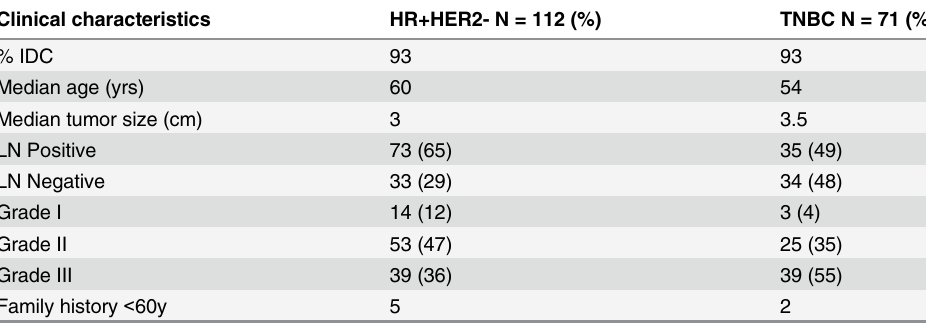
Table 2. Clinical characteristics. Clinical